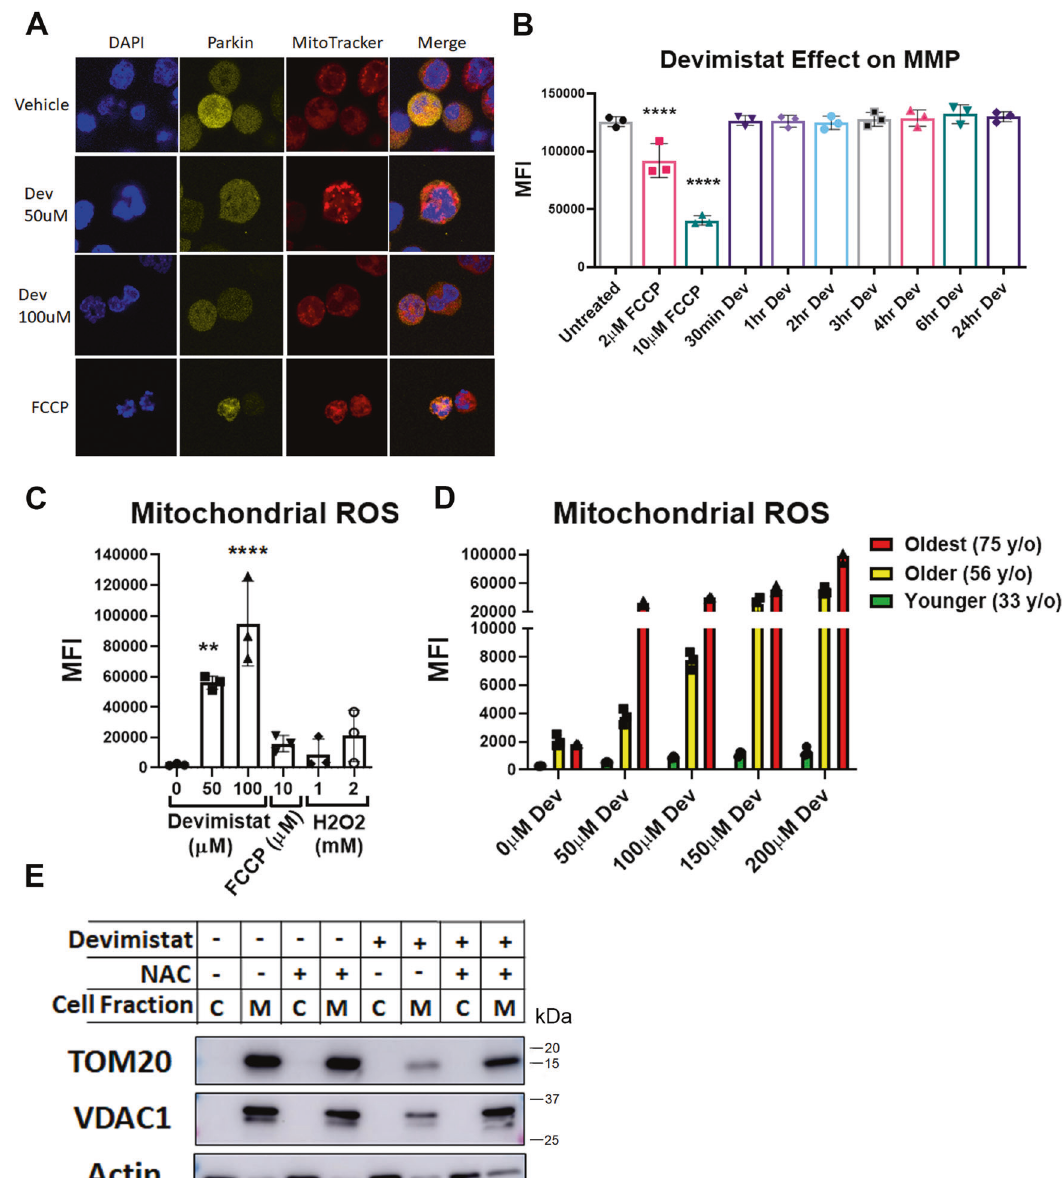
Fig. 6 Devimistat induces mitophagy via mitochondrial ROS. A Immuno fl uorescence. MFL2 cells expressing mCherry-Parkin were treated as indicated for 24 h and imaged using the 60x objective, total magni fi cation of ×600. B MMP assessments. MFL2 cells were treated with FCCP for 6 h or 100 µ M devimistat for the indicated time and stained with TMRM. Means of three independent experiments are shown. C Mitochondrial ROS. MFL2 cells were treated as indicated for 24 h and stained with MitoSOX red to assess mitochondrial ROS. Means of three independent experiments are shown. D Mitochondrial ROS in primary patient-derived AML cells. Primary patient sample-derived AML cells were placed in culture and treated as indicated for 24 h. Cells were then stained with MitoSOX red to assess mitochondrial ROS. Shown are the means of triplicates. E Western blot for Vdac1 and Tom20. MFL2 cells were treated with vehicle, 100 µ M devimistat with or without n-acetyl-cysteine (NAC) as indicated for 24 h, lysed and cytosolic and mitochondrial fractions blotted for the indicated protein. Actin was used as a localization and loading control. For ( B – D ), a mean of three independent experiments are shown. Means compared by two-way ANOVA and multiple comparisons corrected by Sidak ’ s posttest. * P < 0.05, ** P < 0.01, *** P < 0.005, **** P < 0.001. All error bars represent the standard deviation around the